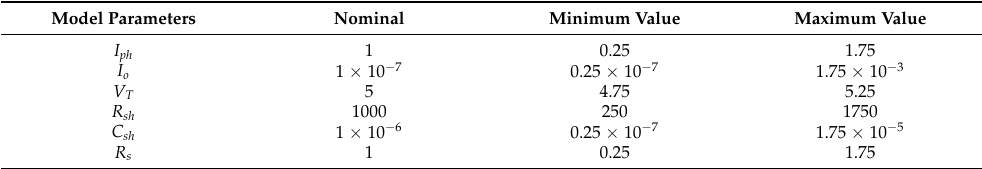
estimated current. The simulation results of the ANN estimator are summarized in Table 2. The dataset consists of 3693 data lines with each data line consists of 50 voltage samples, 50 currents samples in which 2954 data lines are used for training, and 739 data lines are used for testing and performance evaluation. For the ANN1, input dimension